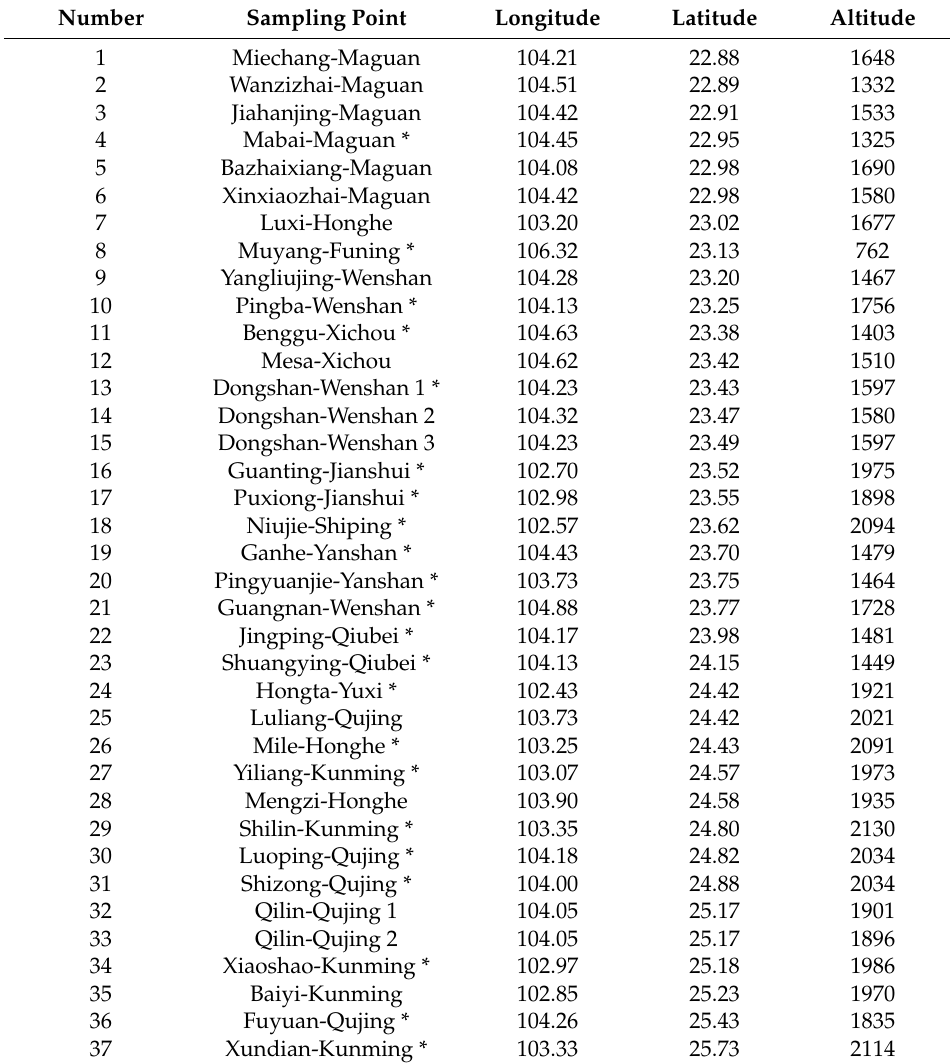
Table 1. Soil and plant sampling points of P. notoginseng cultivation in Yunnan, China.